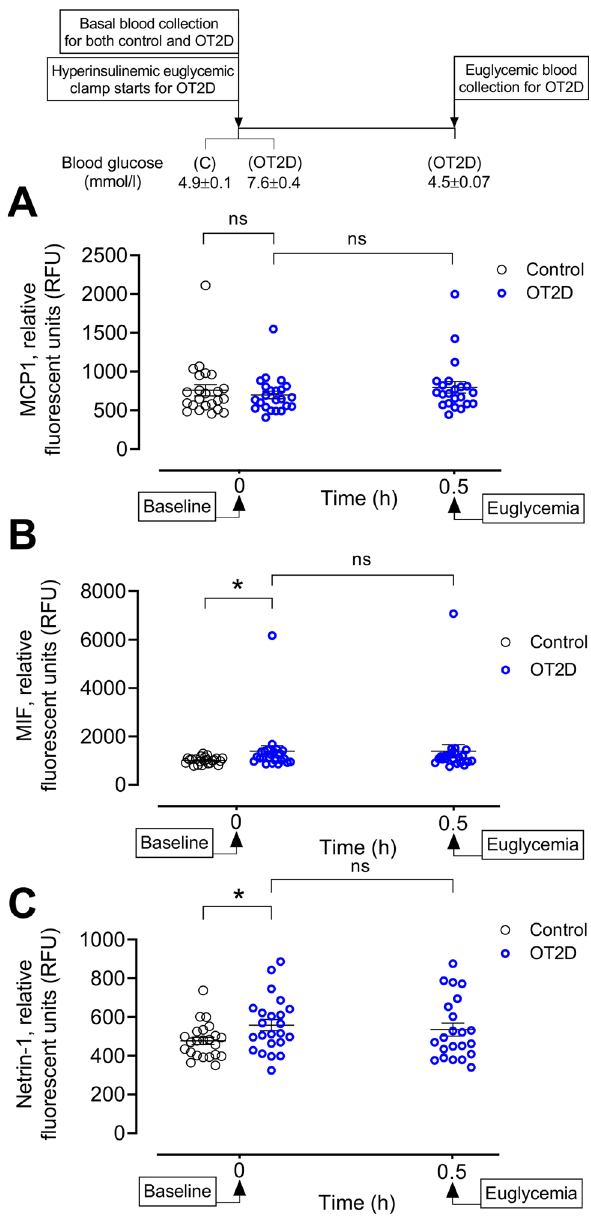
Figure 4. Circulatory levels of adipose tissue macrophage (ATM) markers in the steady state of obese type 2 diabetes (OT2D). Plasma level of MCP-1 ( A ), MIF ( B ) and netrin-1 ( C ) in control subjects (black circles) and obese subjects with T2D (blue circles). Basal level of plasma MCP-1 did not alter in OT2D compared to control (698 ± 49 vs 760 ± 73 RFU of MCP-1, OT2D vs control, p = ns). Basal level of plasma MIF and netrin-1was increased in OT2D (1387 ± 223 vs 1007 ± 29 RFU of MIF-1 and 558 ± 30 vs 478 ± 19 RFU of netrin-1, OT2D vs control, p < 0.05). Acute normalization of glycemia had no effect on levels of LBP, CD80 or CD38 in T2D subjects (A-C). Data were presented as mean ± SEM. *, p <